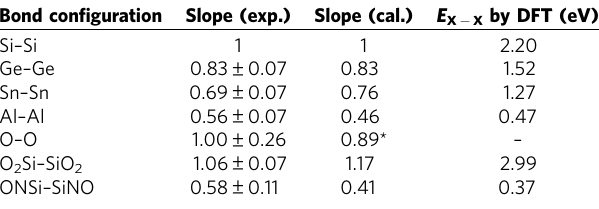
Table 2 | Summary of experimental intercepts D Si (cid:3) X ð Þ